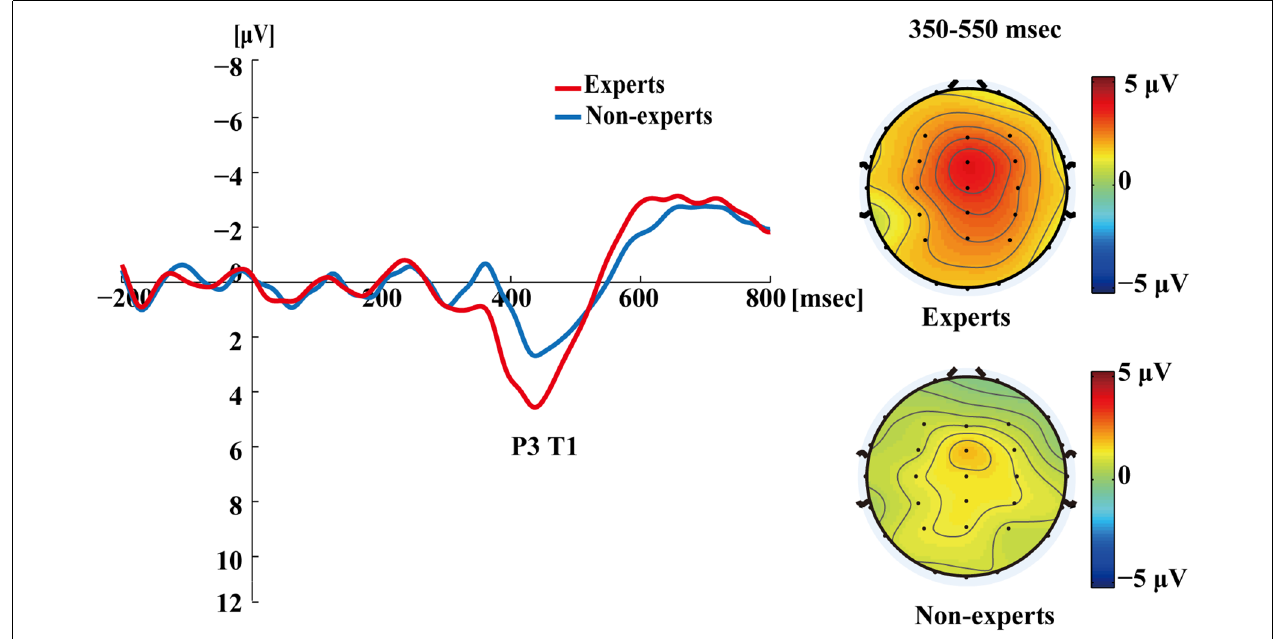
FIGURE 4 | Grand averages of the mean activation at Pz of both experts and non-experts as a function of time for single-target trials. ERPs were time locked to the onset of T1. The scalp distribution of 350–550 ms time windows for single-target condition.